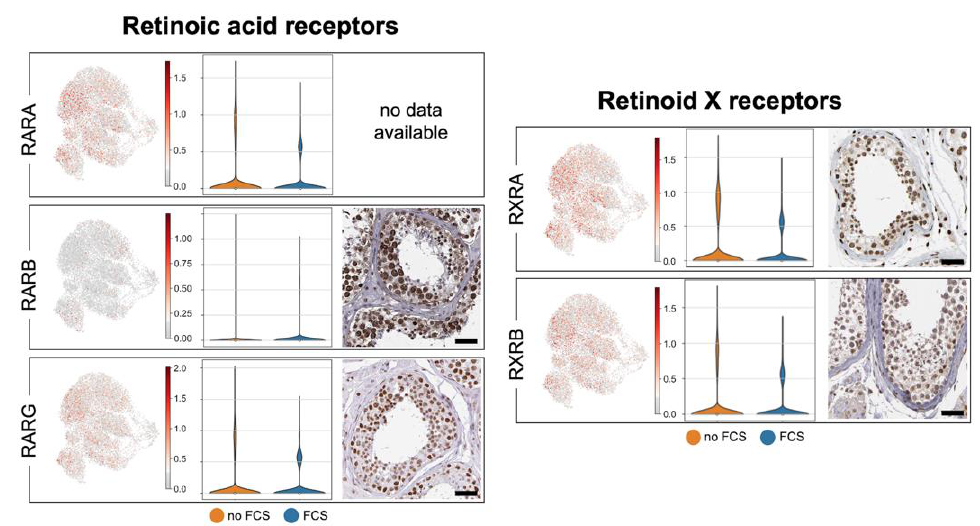
Figure A3. Summary transcript information of retinoic acid and retinoid X receptors. UMAP plots in HTPCs ( left side ). Violin plots, comparing expression with and without FCS of HTPC-1, ( middle ) and corresponding protein detection with HPA-images ( right side ; scale bars = 50 µ m). Note that abundance of some transcripts are affected by FCS. Table A1. Table of HPA-derived images, links and antibody information.